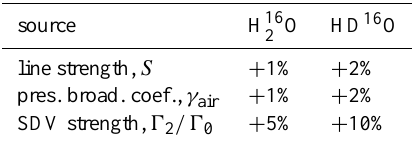
Table 4. Assumed spectroscopic parameter uncertainty for H 16 and HD 16